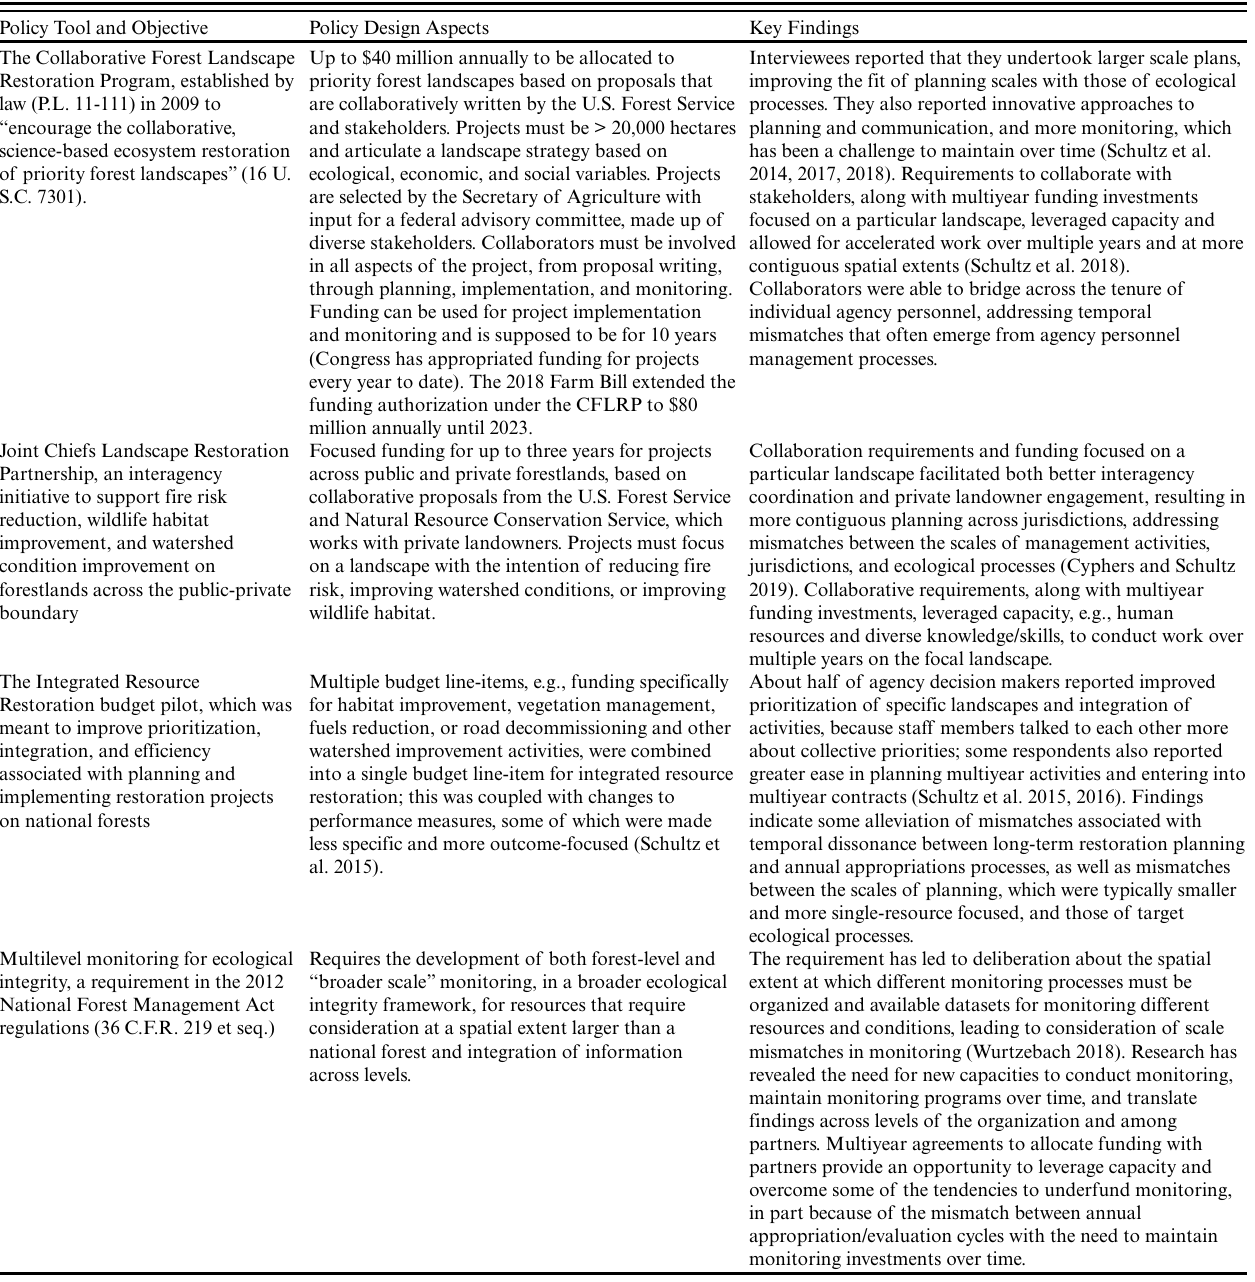
Table 2 . Policy tools, objectives, design, and key findings related to scale